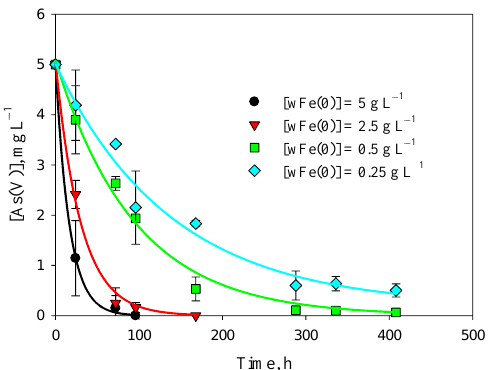
T i m e , h Figure 2. Temporal profiles of As(V) concentration in contact with different doses of wFe(0). Condi- tions: [As(V)] 0 = 5 mg L −1 , pH 7, RT, EC = 0.03 mS cm −1 , without stirring. Error bars represent the standard deviation between duplicates, while full lines are the adjustment to a pseudo-first-order kinetics using Equation (3).